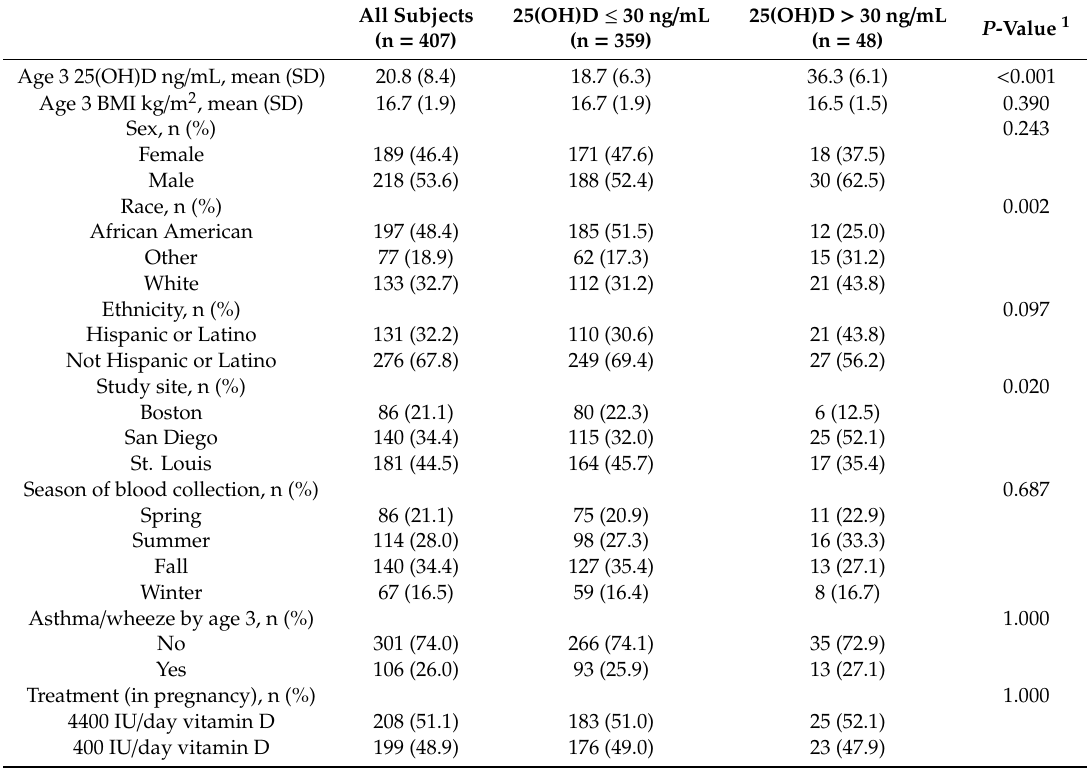
Table 2. Characteristics of VDAART children included in age 3